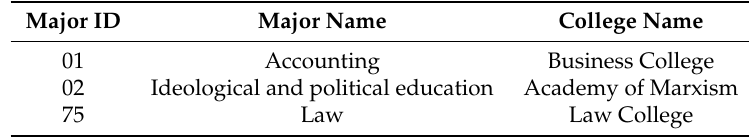
Table 2. Major information form.